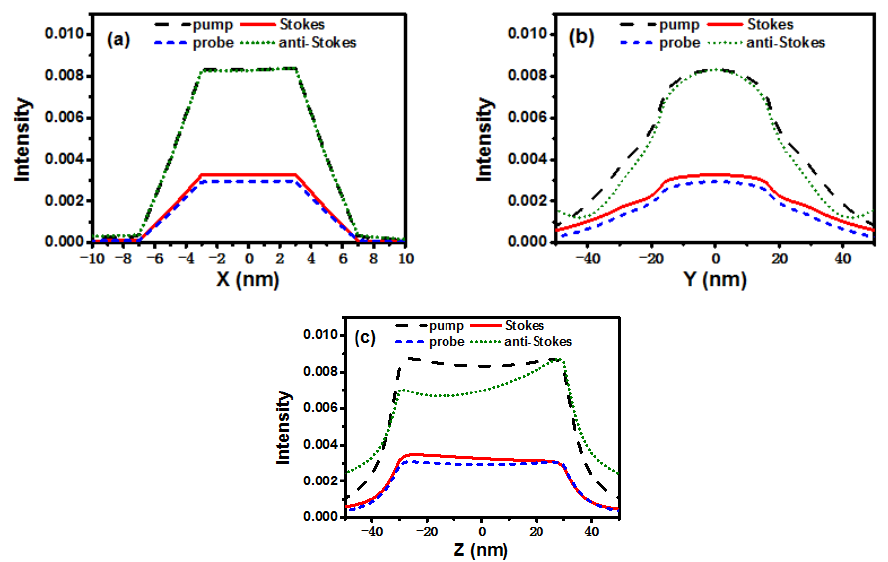
Figure A7. Distribution of the electric field intensity in ( a ) X, ( b ) Y, and ( c ) Z axes for the pump, Stokes, probe, and anti-Stokes light at 7128.3 fs.